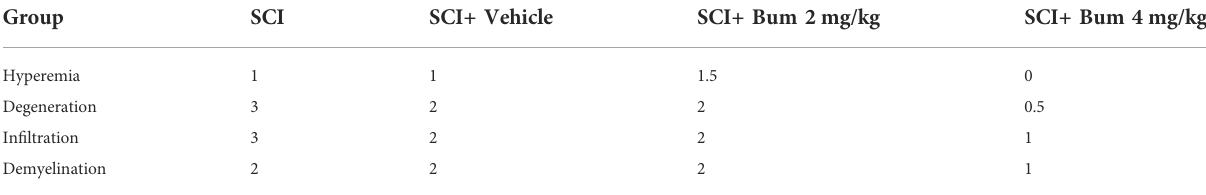
TABLE 1 Comparison of histological changes of late SCI, such a hyperemia, degeneration, cellular in fi ltration, and demyelination between SCI and treatment groups at 4 weeks post SCI. Histological score: 0= (negative); 1= (mild); 2= (moderate); 3= (severe). Group